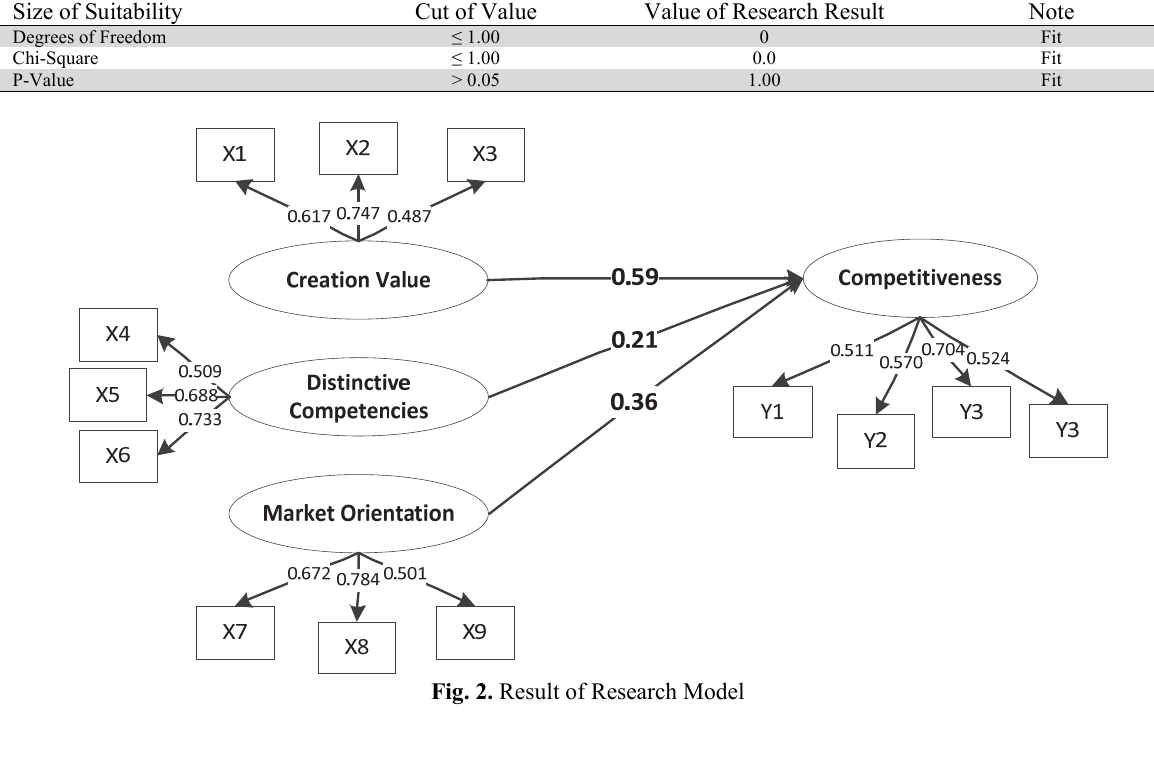
Fig. 2. Result of Research Model